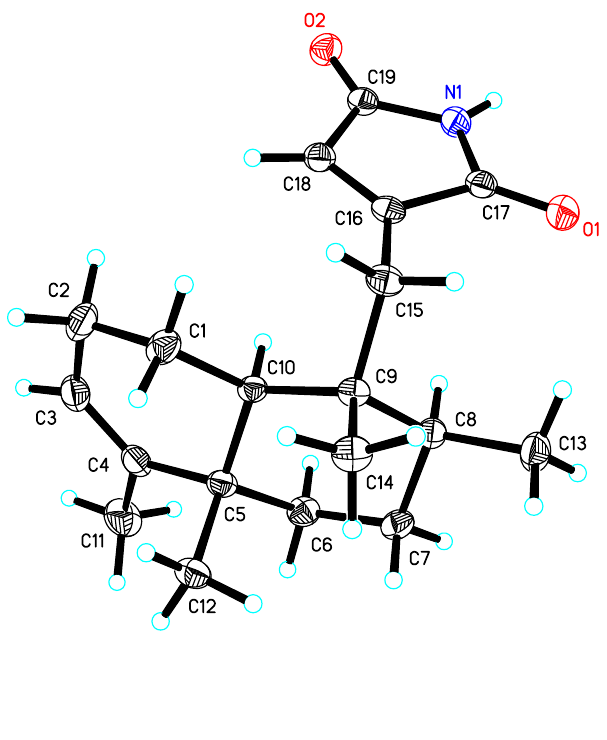
Figure 3. X-ray ORTEP drawing of dysidinoid A ( 1